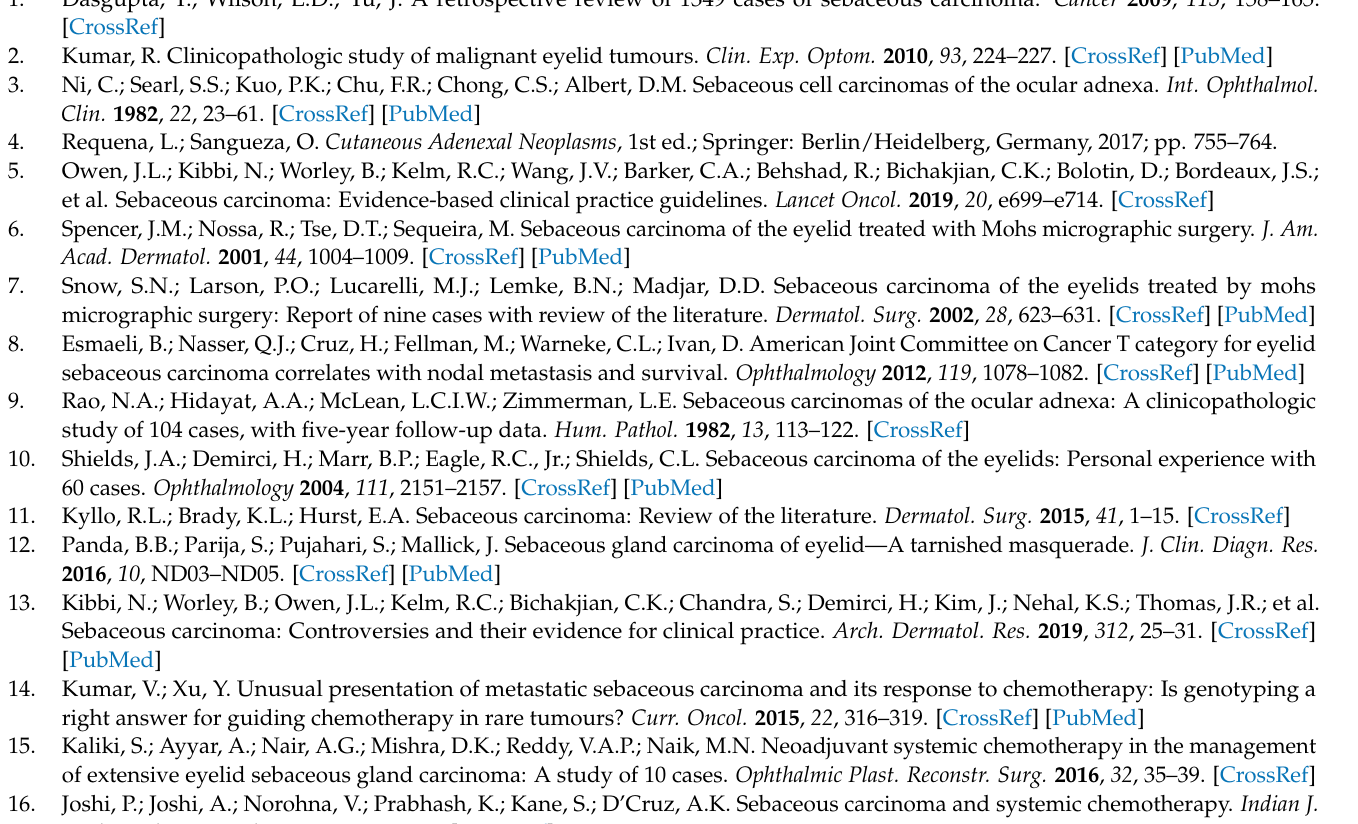
Table S4: Cases showing alterations in mismatch repair